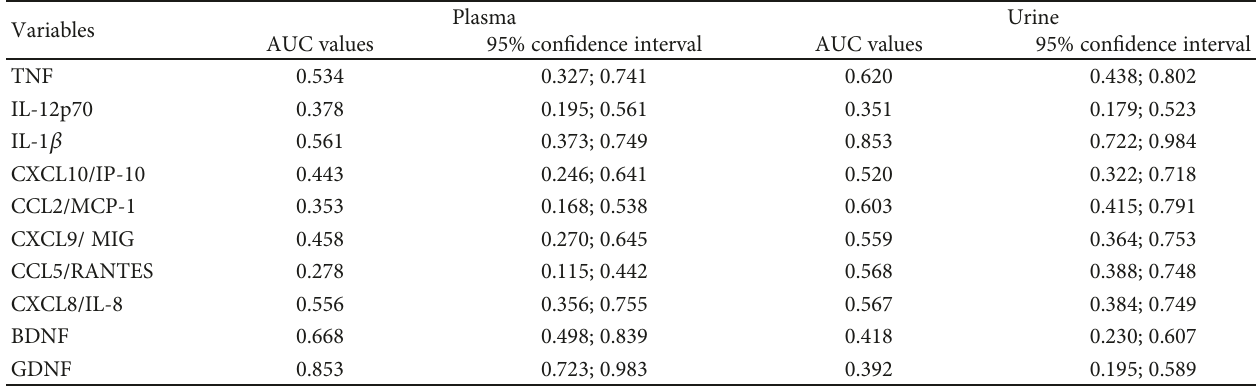
Table 2: Area under the curve (AUC) values for the measurement of in fl ammatory markers and neurotrophic factors in plasma and urine